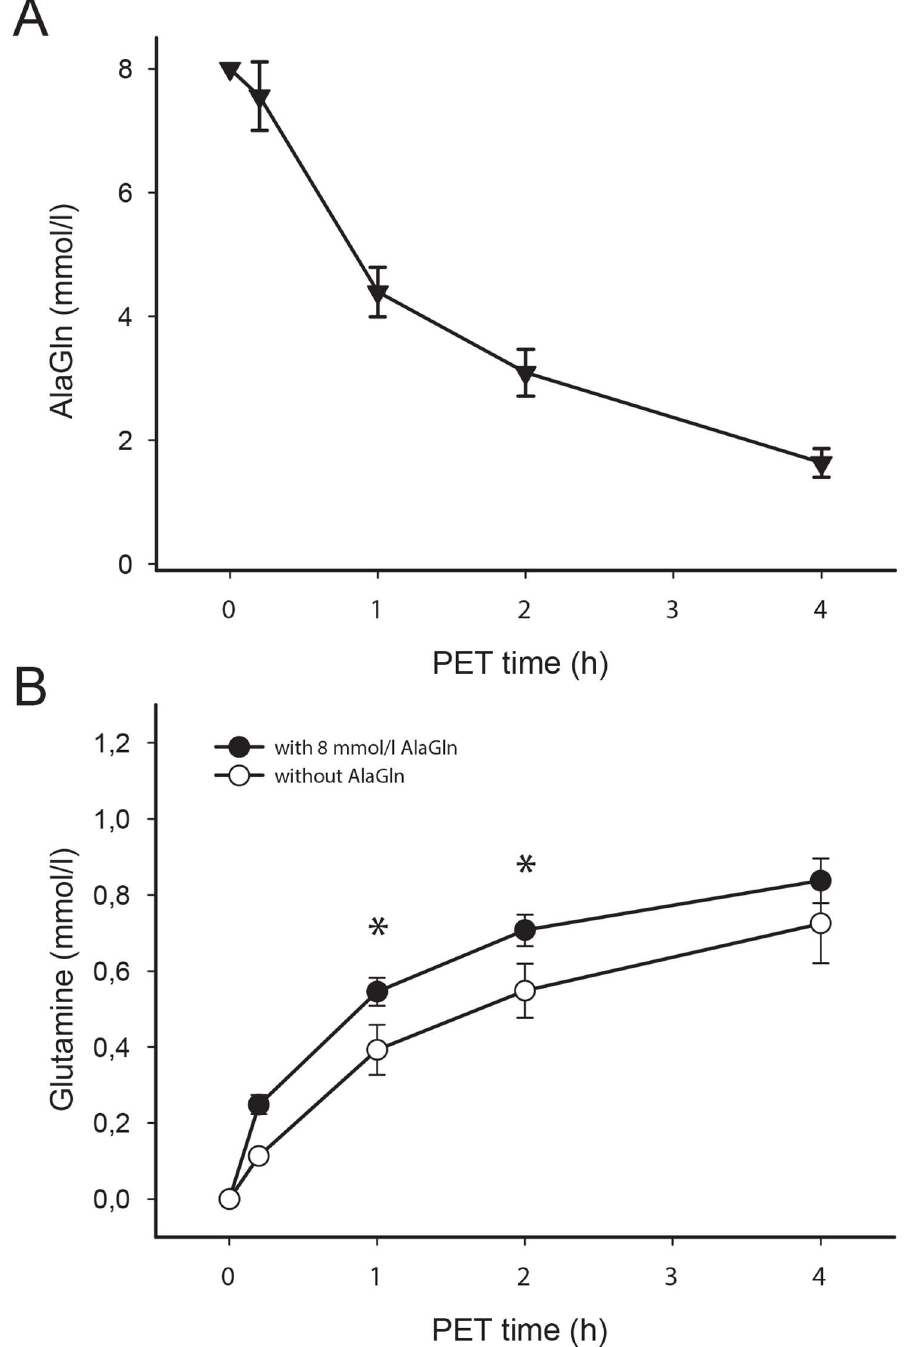
Fig 2. Temporal profile of dialysate glutamine and AlaGln dipeptide with standard PDF and with PDF containing 8 mM AlaGln. To assess transfer kinetics, AlaGln dipeptideand glutaminewere analyzedin dialysatespecimens sampled at baseline(immediately after completion of infusion), 1 h, 2 h and 4 h after initiationof the PET. As shown in panel A, peritonealfluid AlaGln dipeptideconcentration declined from 7.5 mmol/l immediately after infusion to < 2 mmol/l within four hours. The first-order elimination half-life of AlaGln dipeptidefrom the dialysate was 1.07 h. The value at time 0 h was set to 8 mM (as added to standard PDF). Panel B shows that glutamineconcentrations in standard PDF remained below normal (serum) levels after 2 hours, but were significantly higher after 1 h and 2 h in the presence of added AlaGln. Data are shown as means and standard errors. Asterisk indicates p < 0.05 vs . standard PDF (without